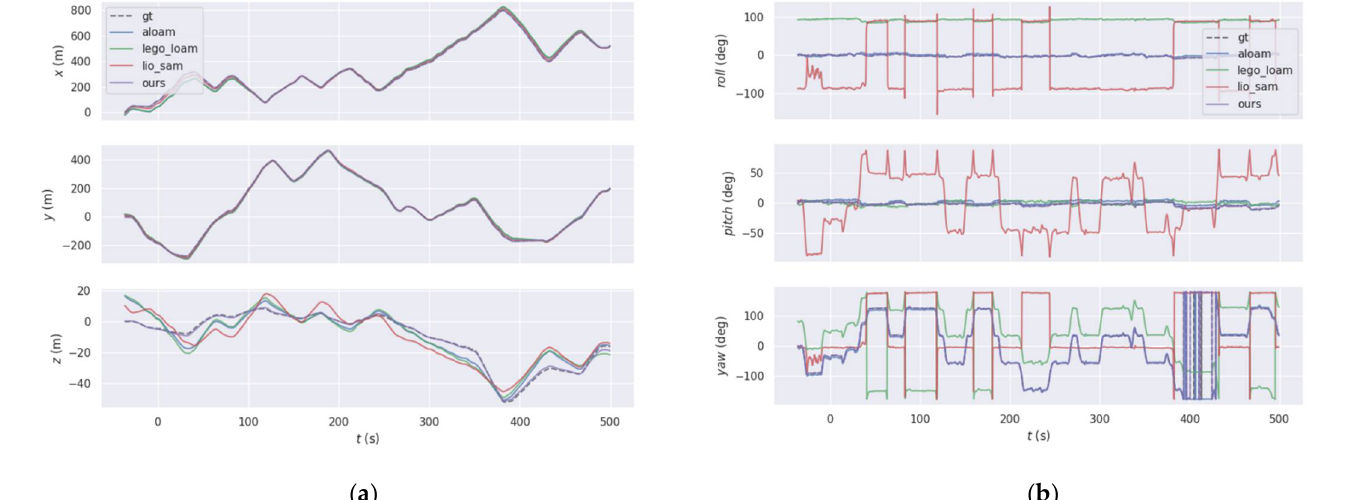
Figure 3. Comparison between the motion trajectories generated by the four different algorithms and the true values.